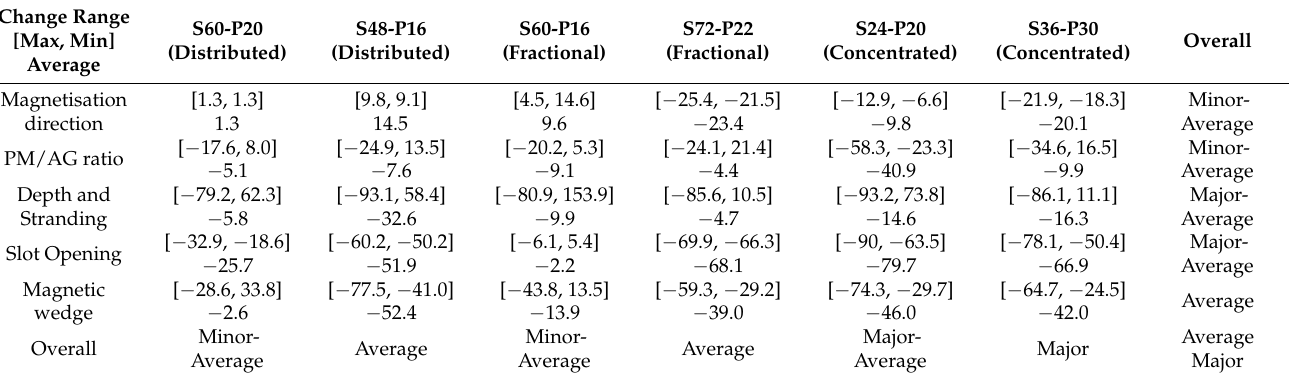
Table 10. Percentage change of AC losses compared to initial design quantitative comparison *.